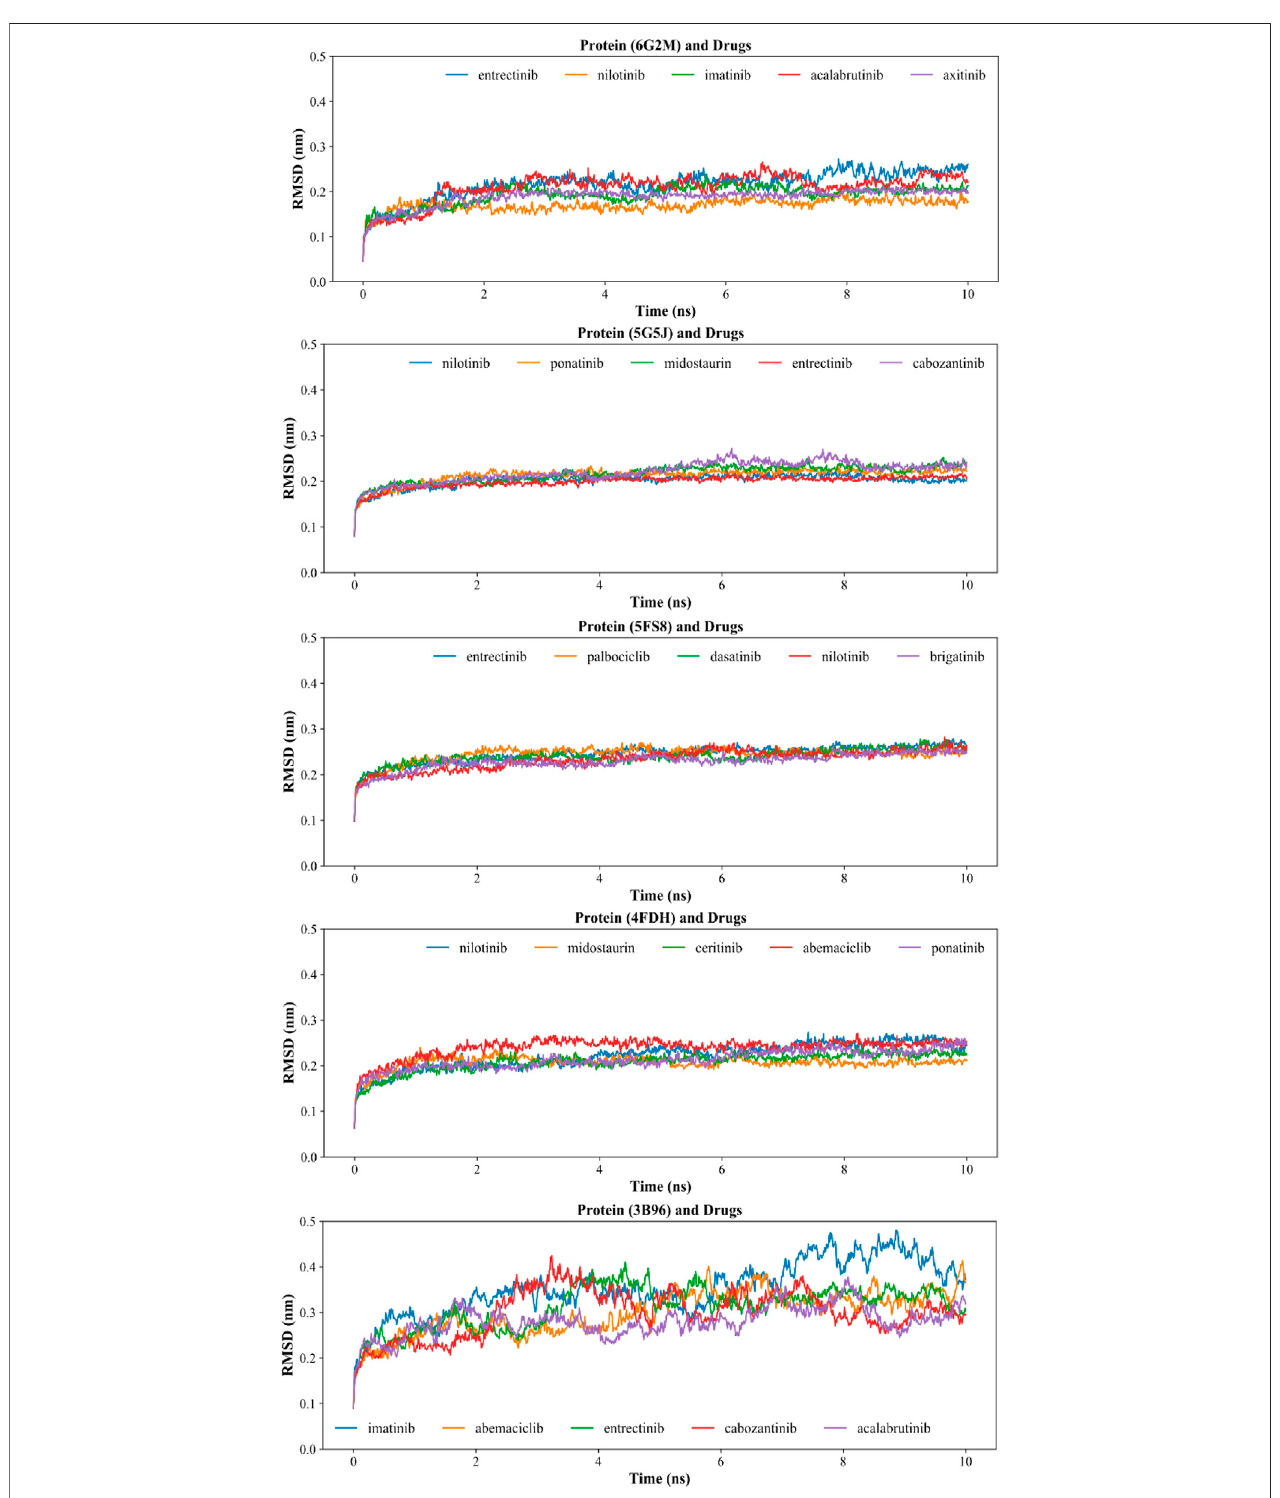
FIGURE 7 | Backbone RMSD of molecular dynamics simulation ofproteins and drug molecules. The codes in the title brackets were the PDB ID corresponding to the proteins in the complexes.